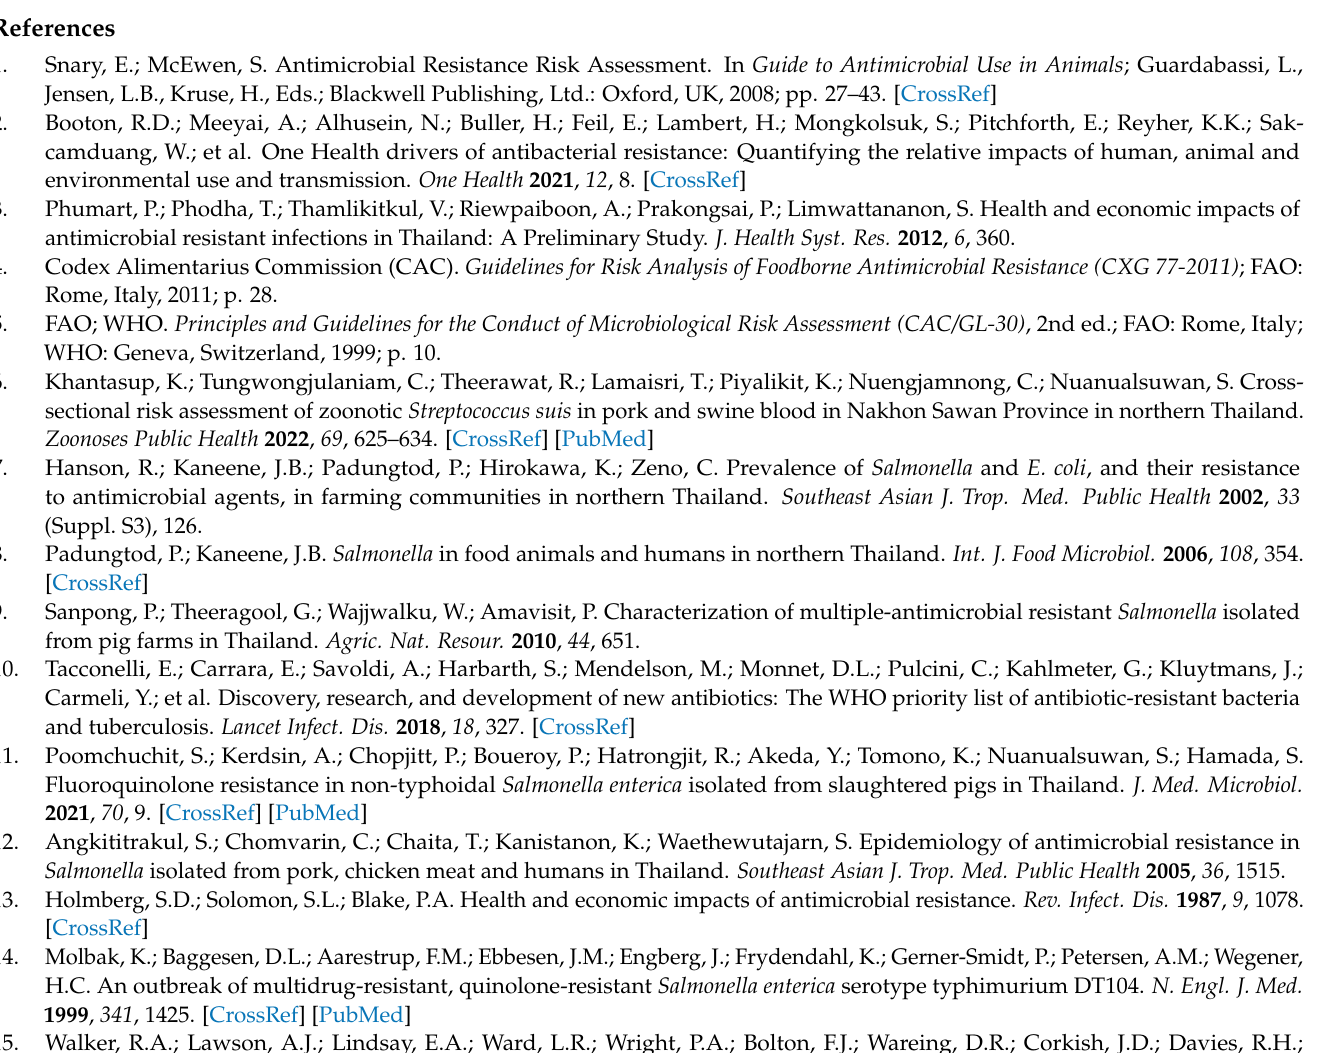
Table S2. Primers for plasmid-mediated colistin resistance genes ( mcr-1-mcr-9 ); Table S3. Primers for plasmid-mediated quinolone resistance (PMQR) genes; Table S4. Primers for quinolone resistance- determining region (QRDR) genes. References [56–58] are cited in the Supplementary